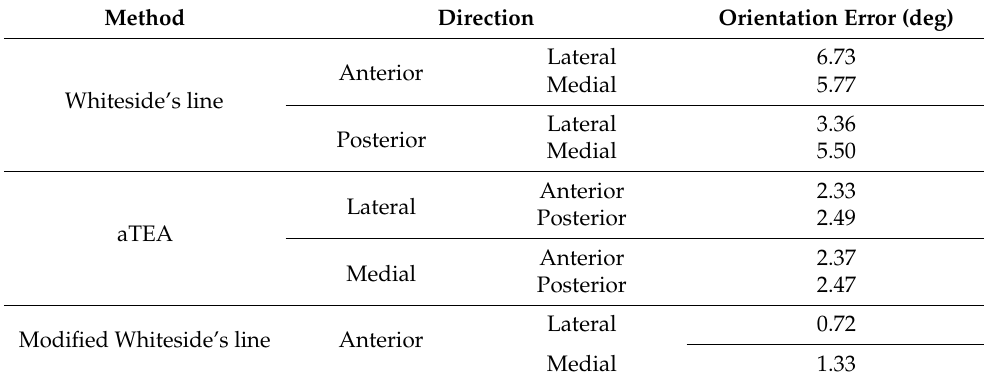
Table 3. Comparison of orientation errors of each method depending on 3 mm registration